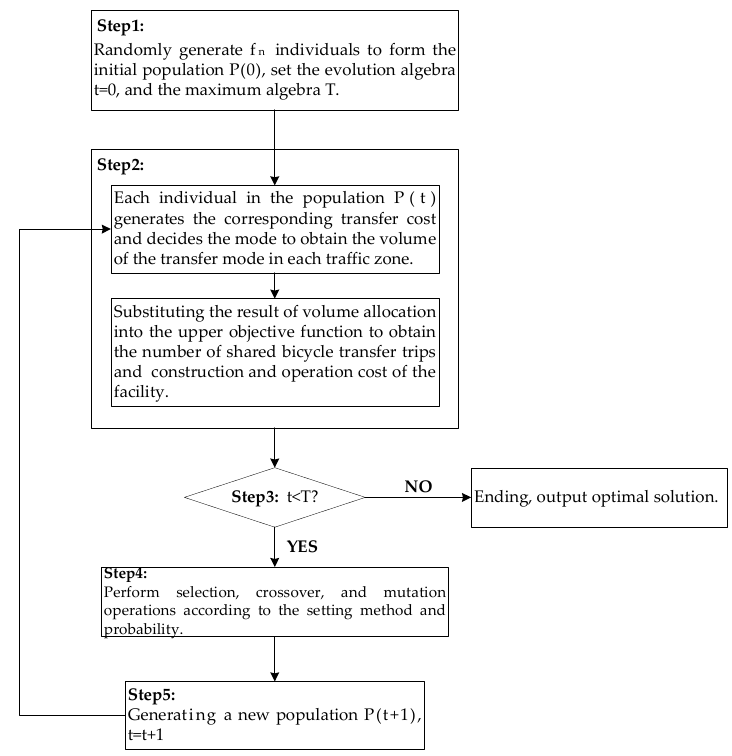
Figure 2. Flow chart of genetic algorithm.